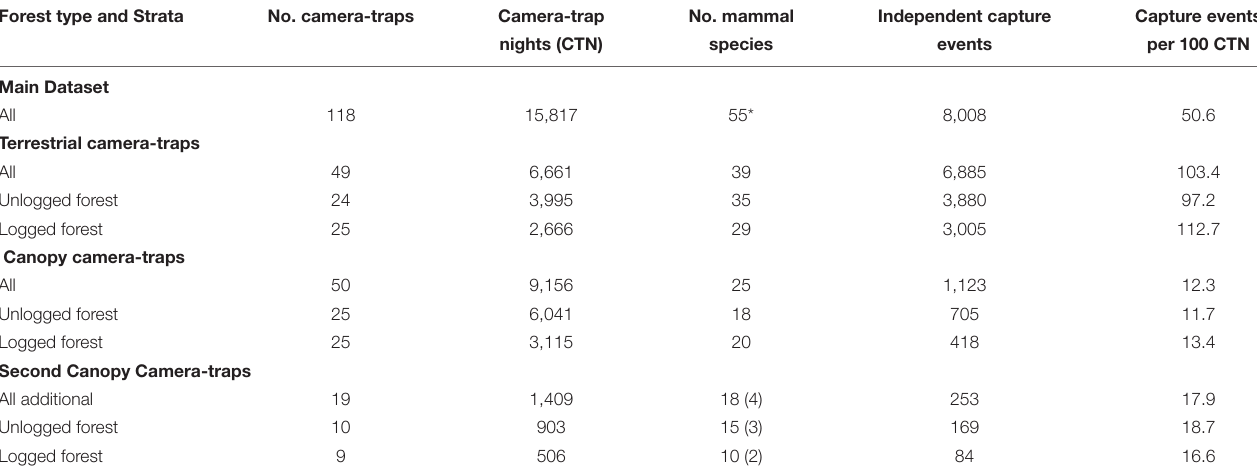
TABLE 1 | Sampling effort, mammal species recorded and number of independent capture events for camera-traps set in terrestrial and canopy strata of unlogged and logged forest in Borneo. Forest type and